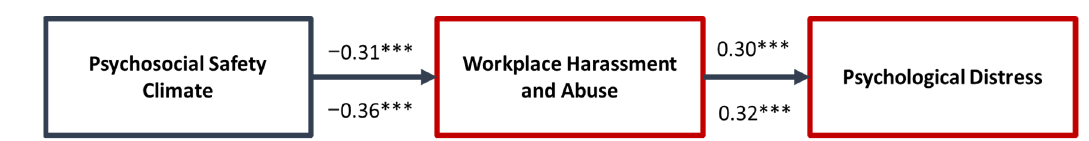
Figure 1. PSC effect on psychological distress via mediating role of workplace harassment and abuse. ***, p < 0.001